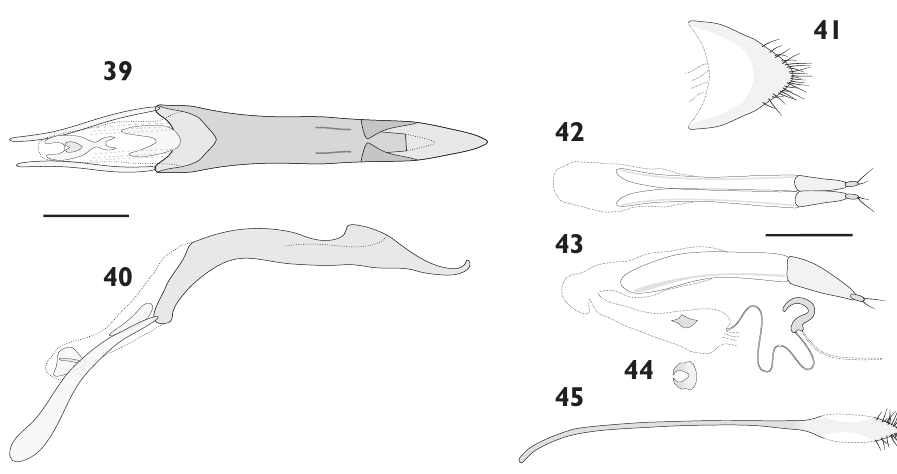
Figures 39–45. Genitalia of Austromonticola atriarius . 39 penis, dorsal view 40 aedeagus, lateral view 41 female tergite 8, dorsal view 42 ovipositor, dorsal view 43 ovipositor and spermatheca, lateral view 44 bursal sclerite, ventral view 45 female sternite 8, ventral view. Scale bars = 0.5 mm; 39–40 at same scale; 41–45 at same scale.